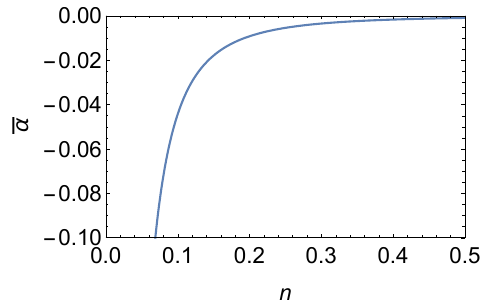
Figure 7 . The line of existence of the solution in the (¯ α, n ) parameter space in f ( R ) = R + αR 3 gravity. The blue solid curve stands for the parameter range of our solution for n > 0 . We only give a schematic diagram in the domain n ∈ (0 , 0 . 5) . It is worth noting that the blue line of ¯ α approaches to zero from an infinite negative value with increasing n .